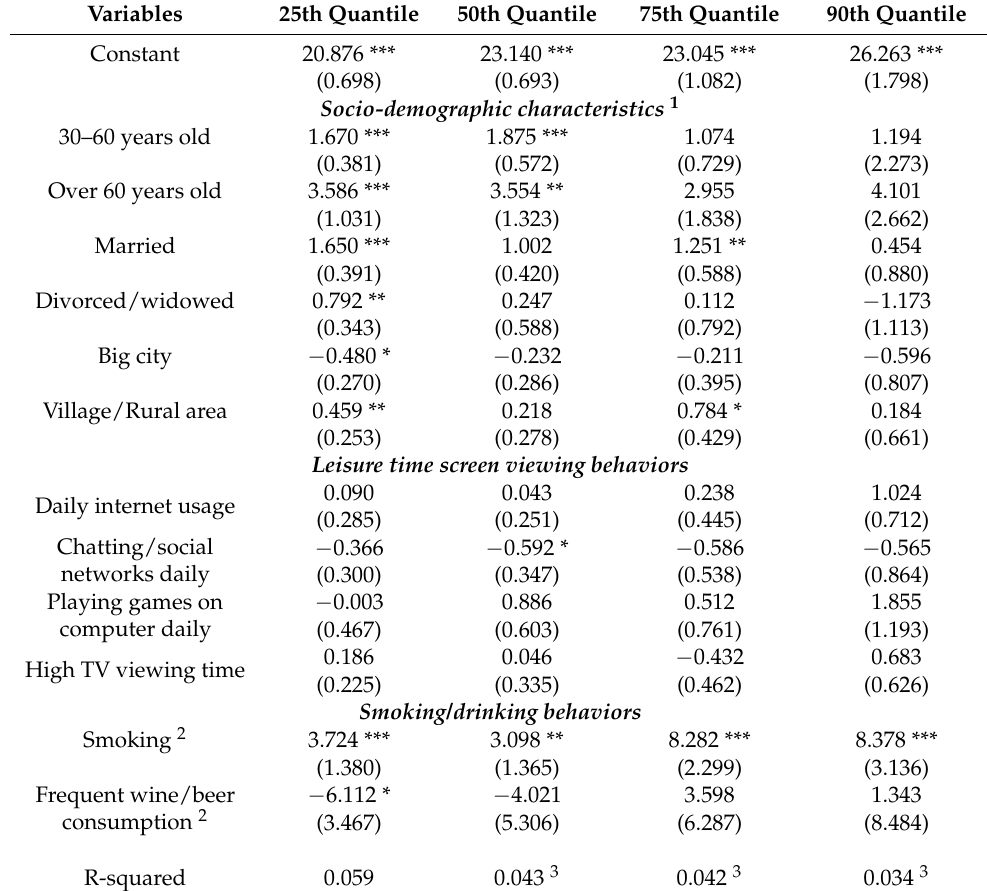
Table 5. Quantile regression estimates for male participants’